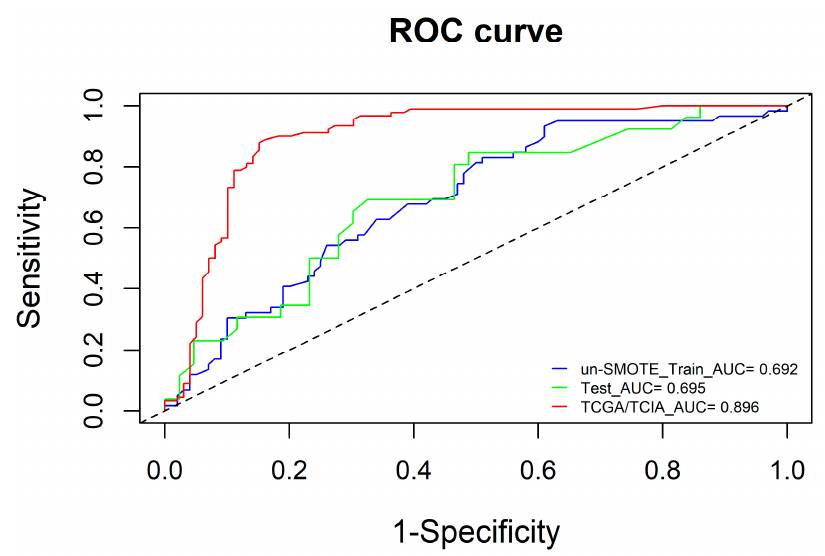
Figure 7. Variables included in the clinical model with the OR values of each variable and its 95% CI and p values.